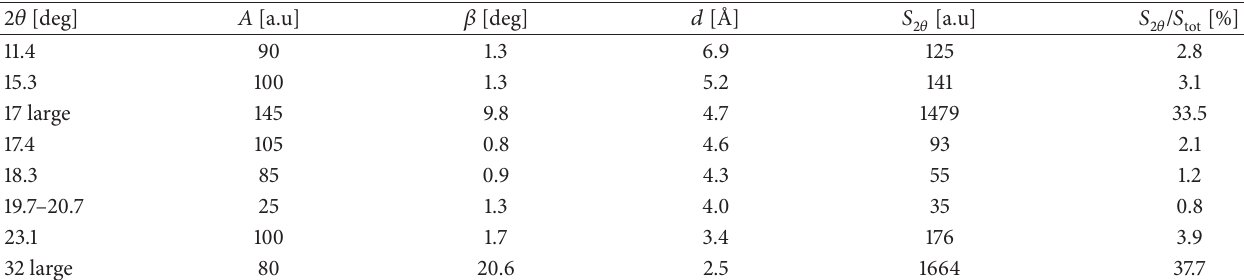
Table 2: Parameters of the XRD spectrum of the starch in initial state.